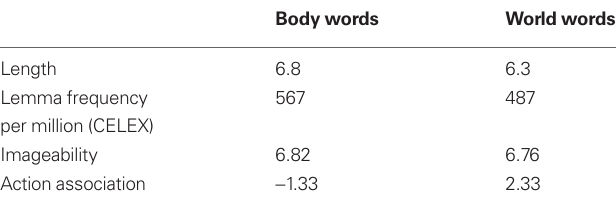
Table 2 | Mean ratings of the pre-tests. Body words World